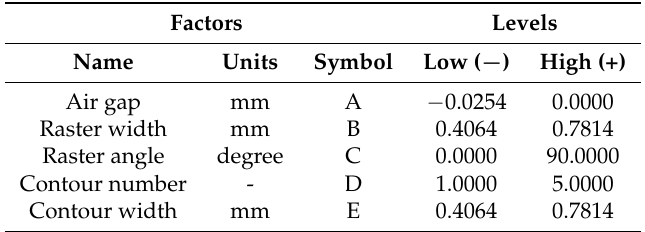
Table 1. FDM process parameters with their respective